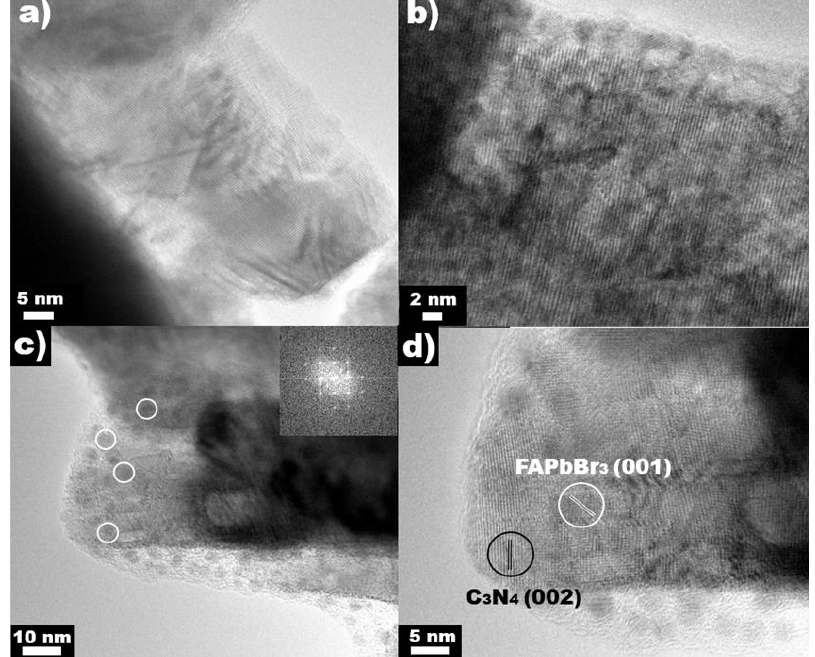
Figure 1. ( a ) TEM image of the pristine g-C 3 N 4 nanoplate; ( b ) HRTEM image of FAPbBr 3 /C 3 N 4 hybrids; ( c ) FAPbBr 3 /C 3 N 4 hybrids in which the FAPbBr 3 nanocrystals are labelled by white circle with SAED on the right top in this image; ( d ) the lattice fringes of g-C 3 N 4 (002) and FAPbBr 3 (001), respectively.